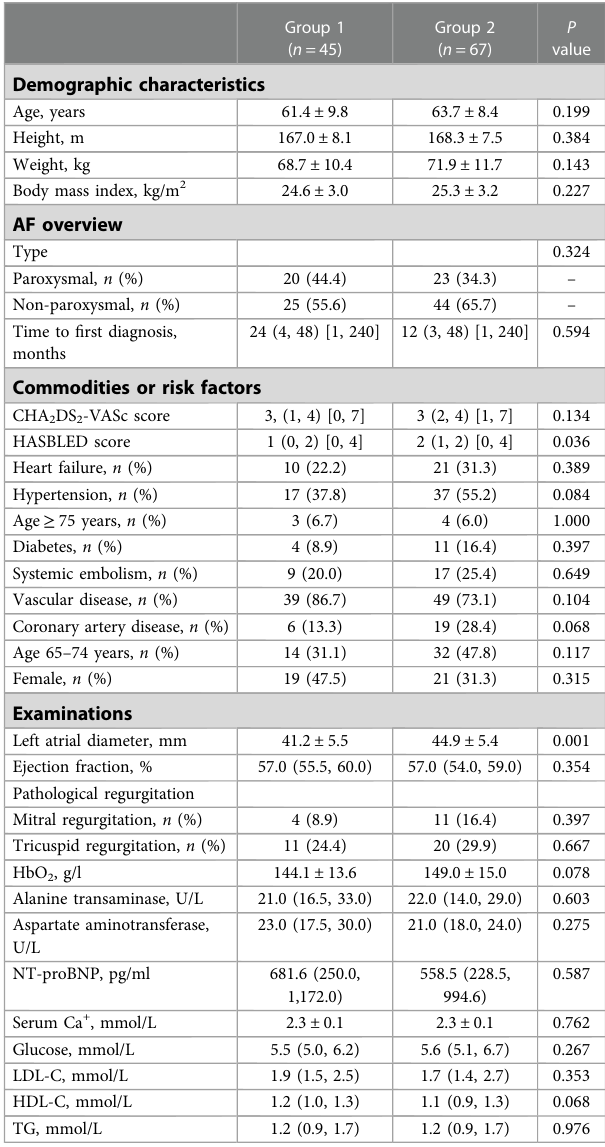
TABLE 1 Patient characteristics at